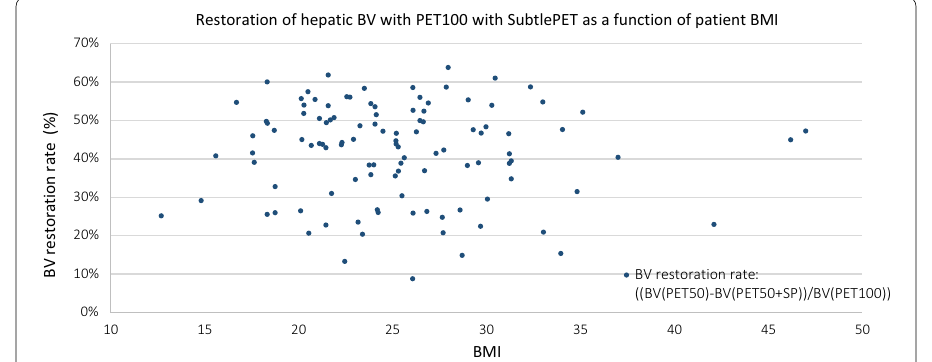
Fig. 8 Scatter plot of the restoration of the hepathic Background Variability with respect to PET100 obtained with SubtlePET, as a function of the patient BMI, for the 110